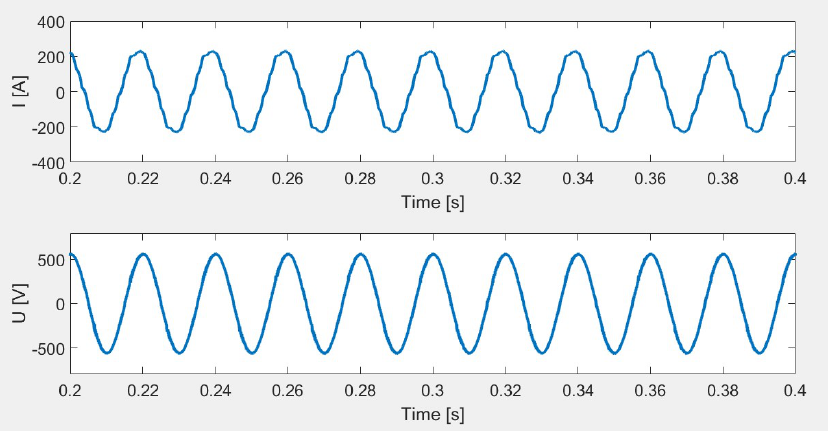
Figure 13. Current and voltage of the transformer supplying a 200 kW charger.